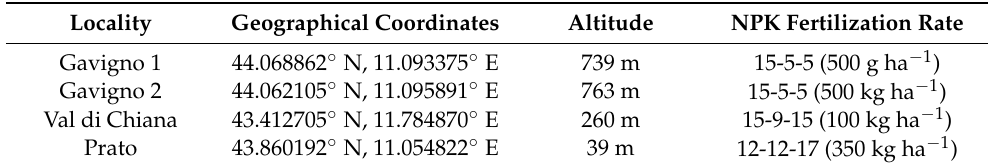
Table 1. Sampling sites analyzed in this study. The locality; geographical coordinates; and nitrogen (N), phosphorus (P), and potassium (K) fertilization rates are